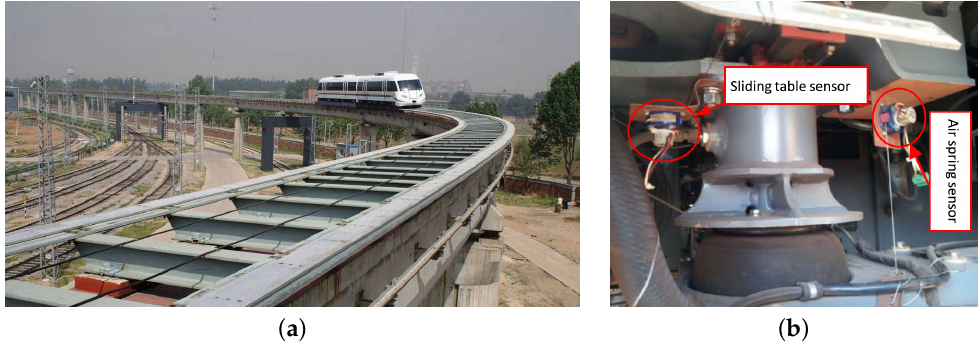
Figure 8. Test on circular curve. ( a ) Maglev train running on R100m circular curve on the Tangshan test line; ( b ) sensor for displacement test of sliding table and air